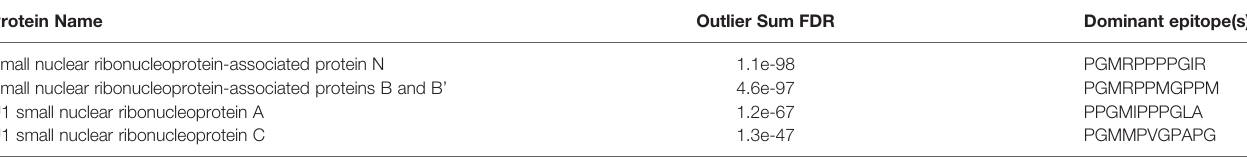
TABLE 2 | Dominant PIWAS epitopes for top antigens from anti-Smith seropositive specimens. Protein